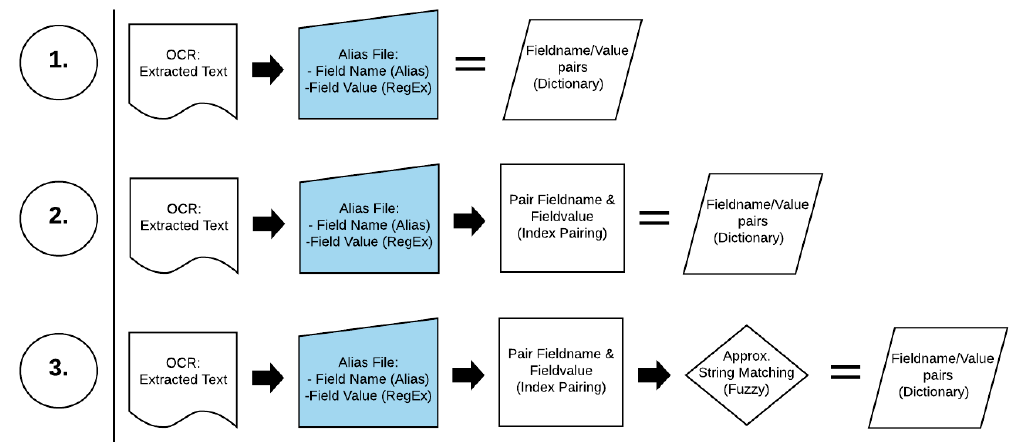
Figure 6. Accuracy measurement points in workflow to show improvements as new functionality is introduced.